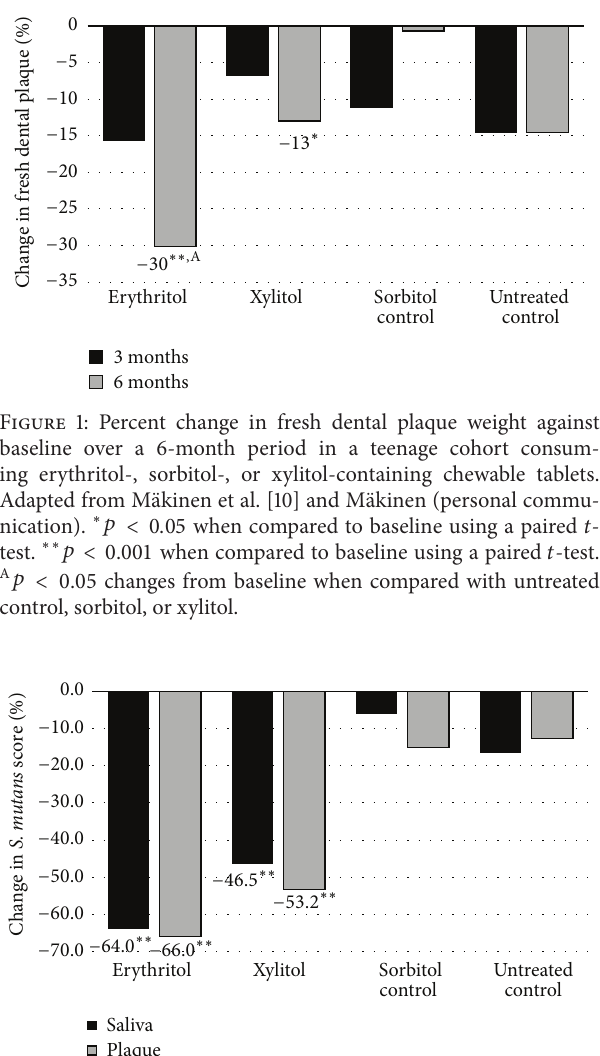
Figure 4: Effect of polyol concentration (g/100mL) on growth of S. mutans (strain 267-S) after 5 hours. Adapted from M¨akinen et al. [10] and M¨akinen